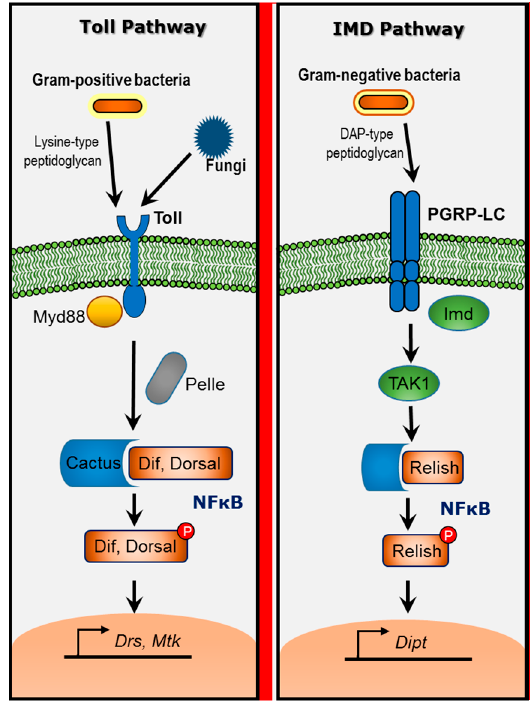
Figure 1. Schematic diagram of innate immune signaling in Drosophila . Toll pathway is activated by Gram ‐ positive bacteria and fungi. Toll activation leads to degradation of Cactus and nuclear localization of NF ‐κ B transcription factors Dif and Dorsal. These transcription factors induce the expression of antimicrobial genes like drosomycin (Drs) and metchnikowin (Mtk). IMD (immune deficiency) pathway is activated by Gram ‐ negative bacteria. IMD activation leads to the nuclear translocation of NF ‐κ B transcription factor Relish to activate the expression of antimicrobial genes like diptericin (Dipt).